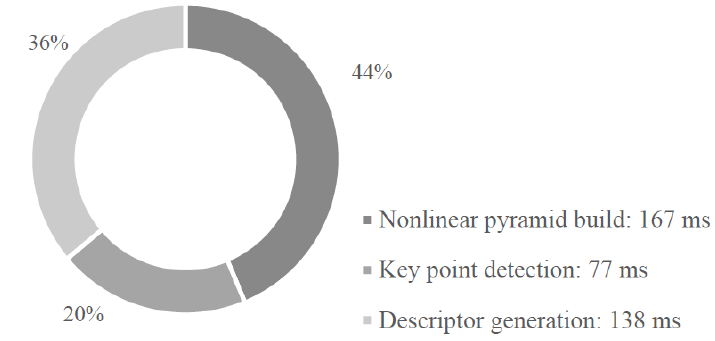
Figure 1. Runtime analysis of AKAZE on PC platform (Intel i5-3210M @2.5